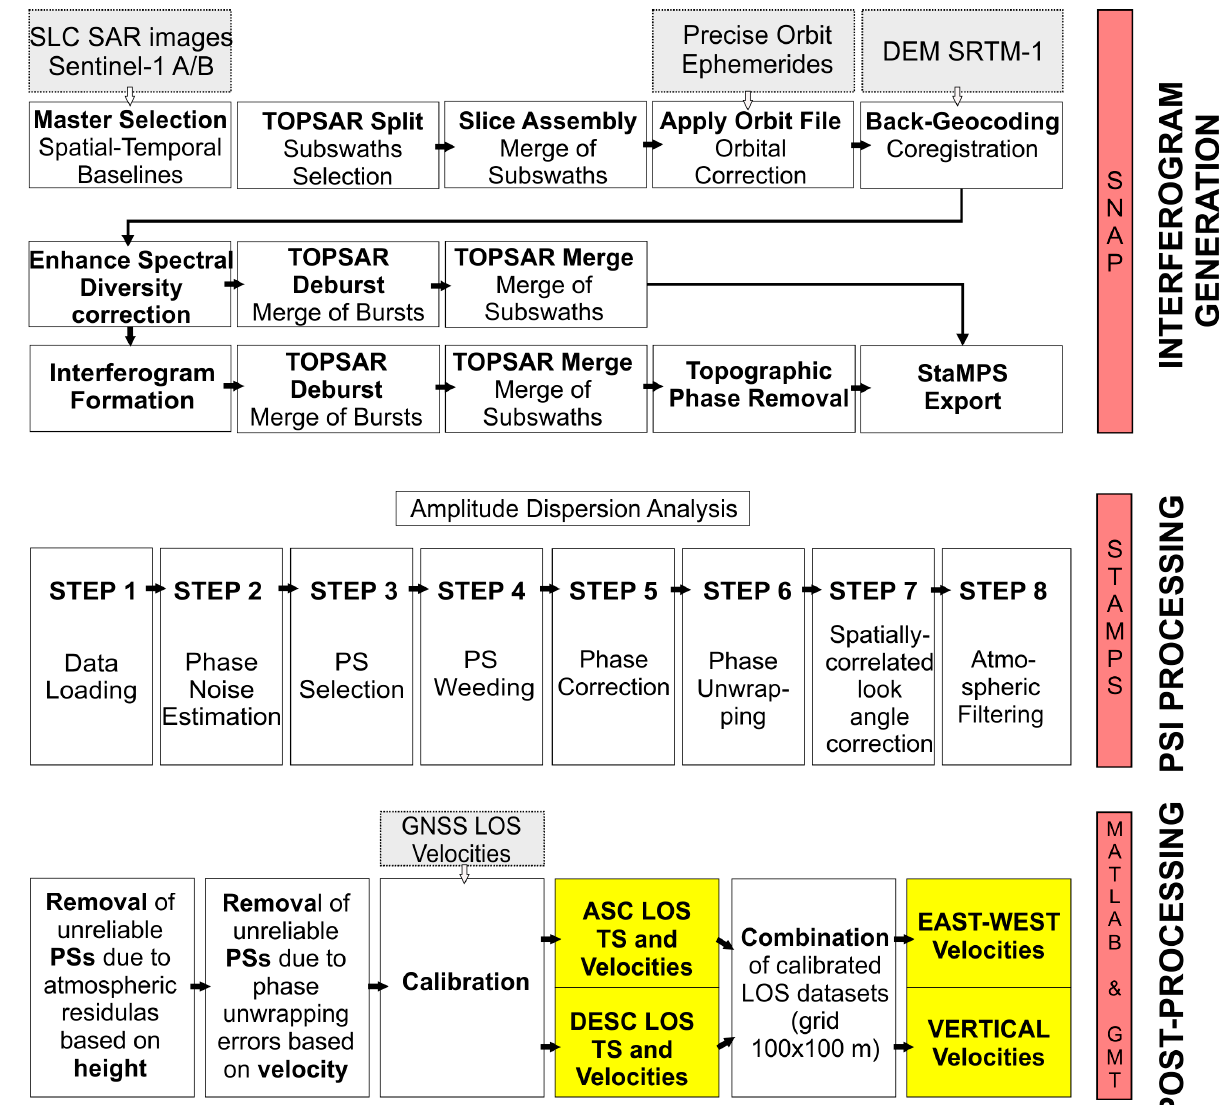
Figure 3. Workflow for PSI processing. The final products, highlighted in yellow, are the velocity maps showing the surface deformation along Line-Of-Sight (LOS) and in the East–West and Vertical directions.